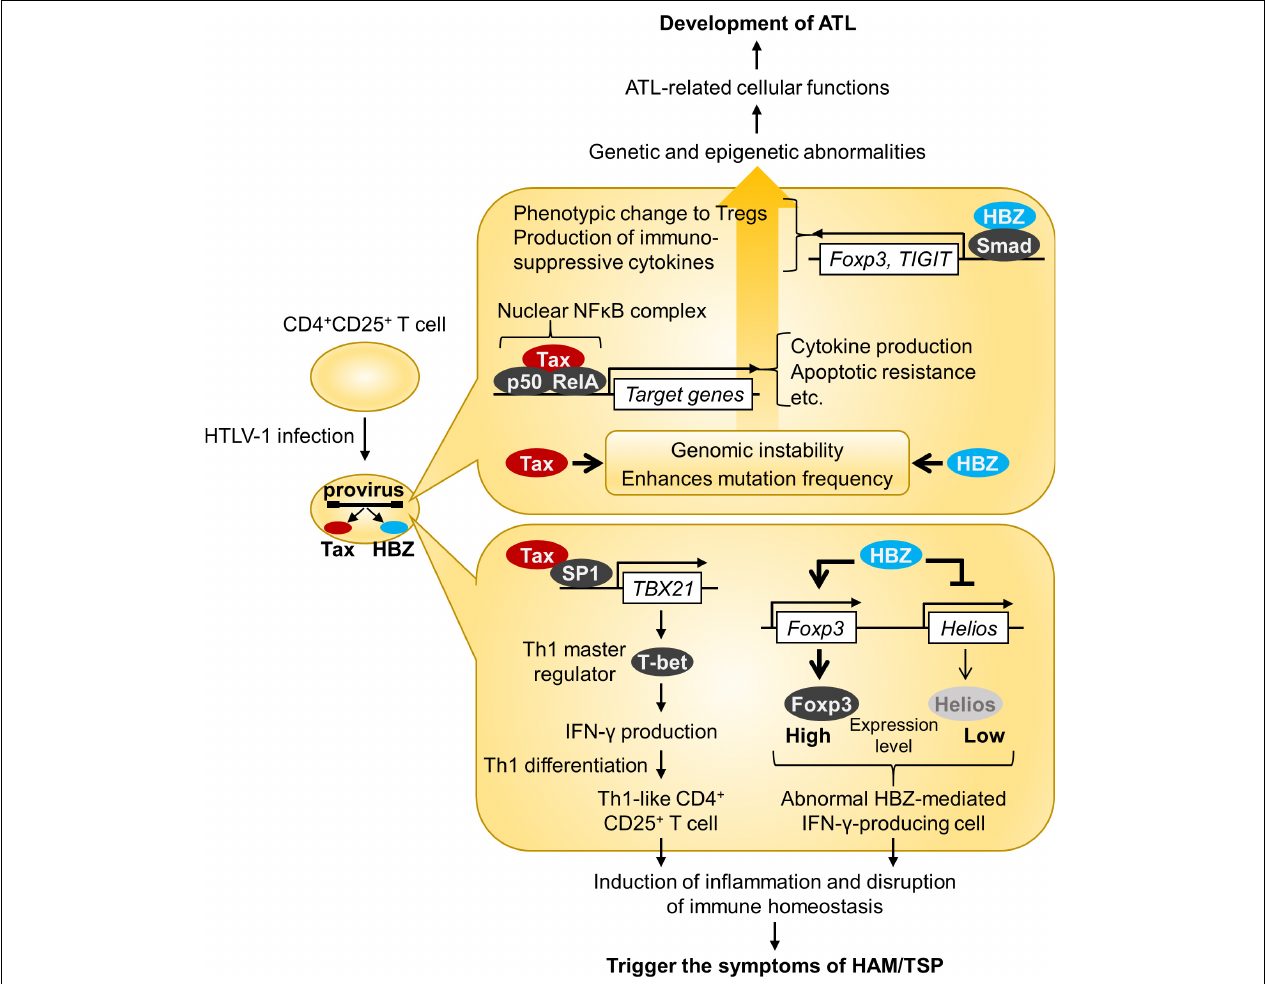
FIGURE 3 | Roles of HTLV-1 Tax and HBZ in the pathogenesis of ATL and HAM/TSP. This figure illustrates the model for ATL and HAM/TSP development. Both Tax and HBZ play crucial roles in oncogenic and inflammatory processes through multiple